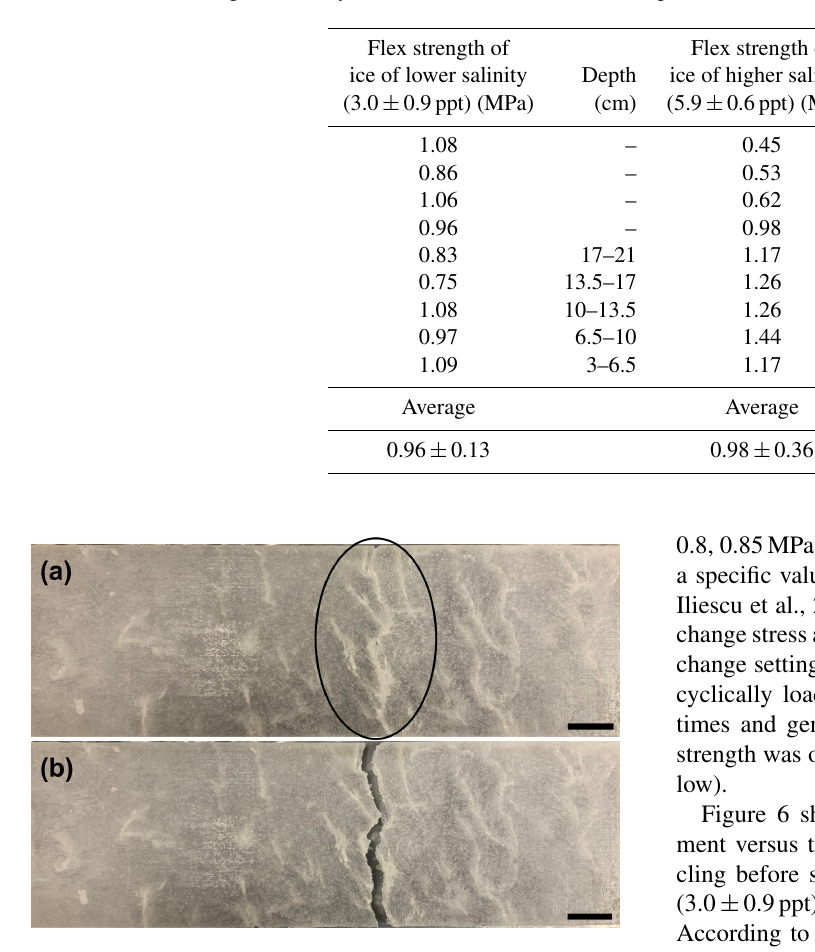
Table 2. Flexural strength of non-cycled saline ice at − 10 ◦ C and a displacement rate of 0.1mms − 1 .